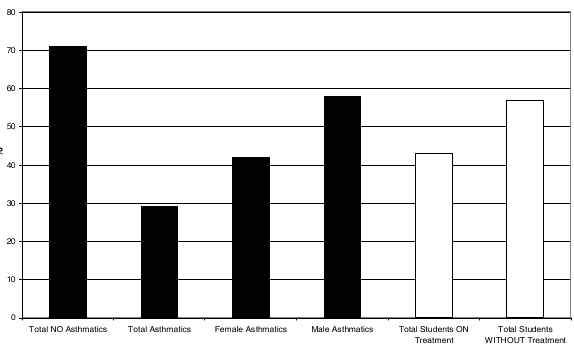
Figure 4: Profile of asthmatic students per gender and in